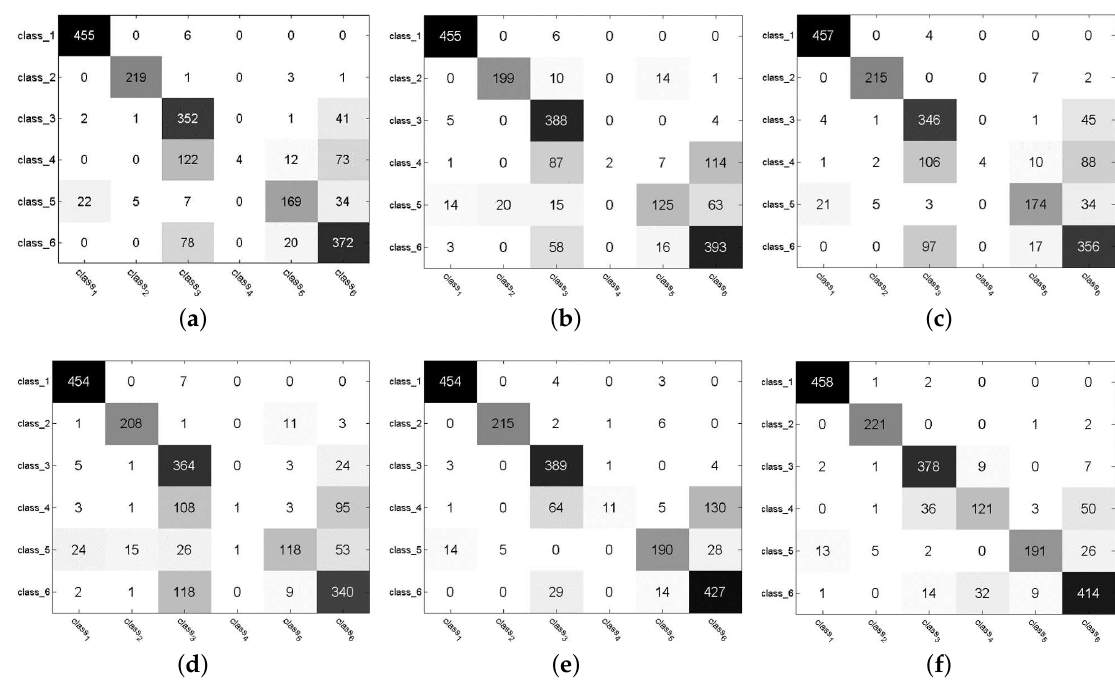
Figure 5. Confusion matrices on Satimage dataset. ( a ) PSD. ( b ) LISTA. ( c ) LAMP. ( d ) LVAMP. ( e ) Tanh. ( f ) Kernel.